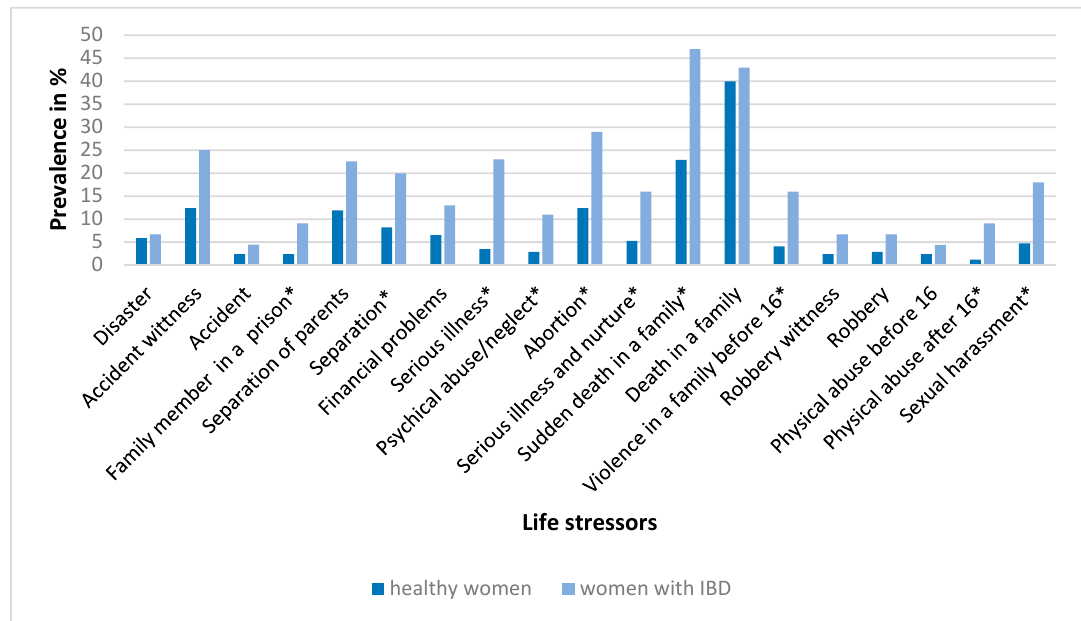
Figure 3. Prevalence of life stressors (%) in the control group of healthy men ( N = 245) and in men with inflammatory bowel disease ( N = 53). Differences in the occurrence of individual life stressors between the groups were assessed by a test of proportions (Z-test); * p < 0.05.